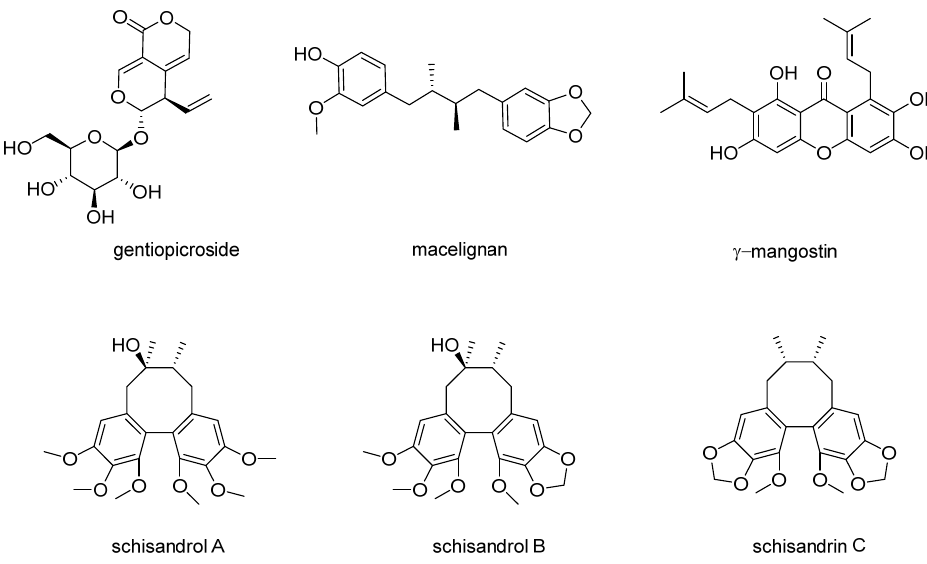
Figure 1. Chemical structures of